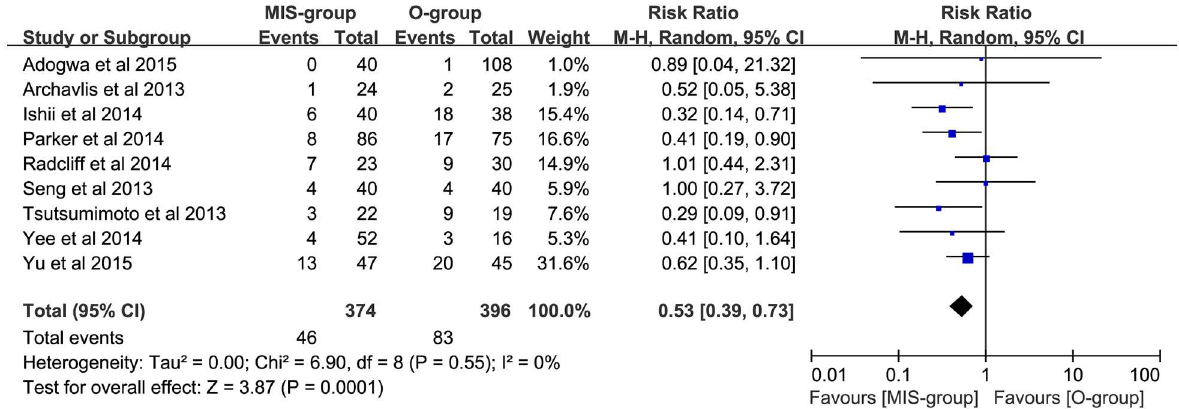
Fig 2. The comparing of ASP incident rate between MIS and open groups.